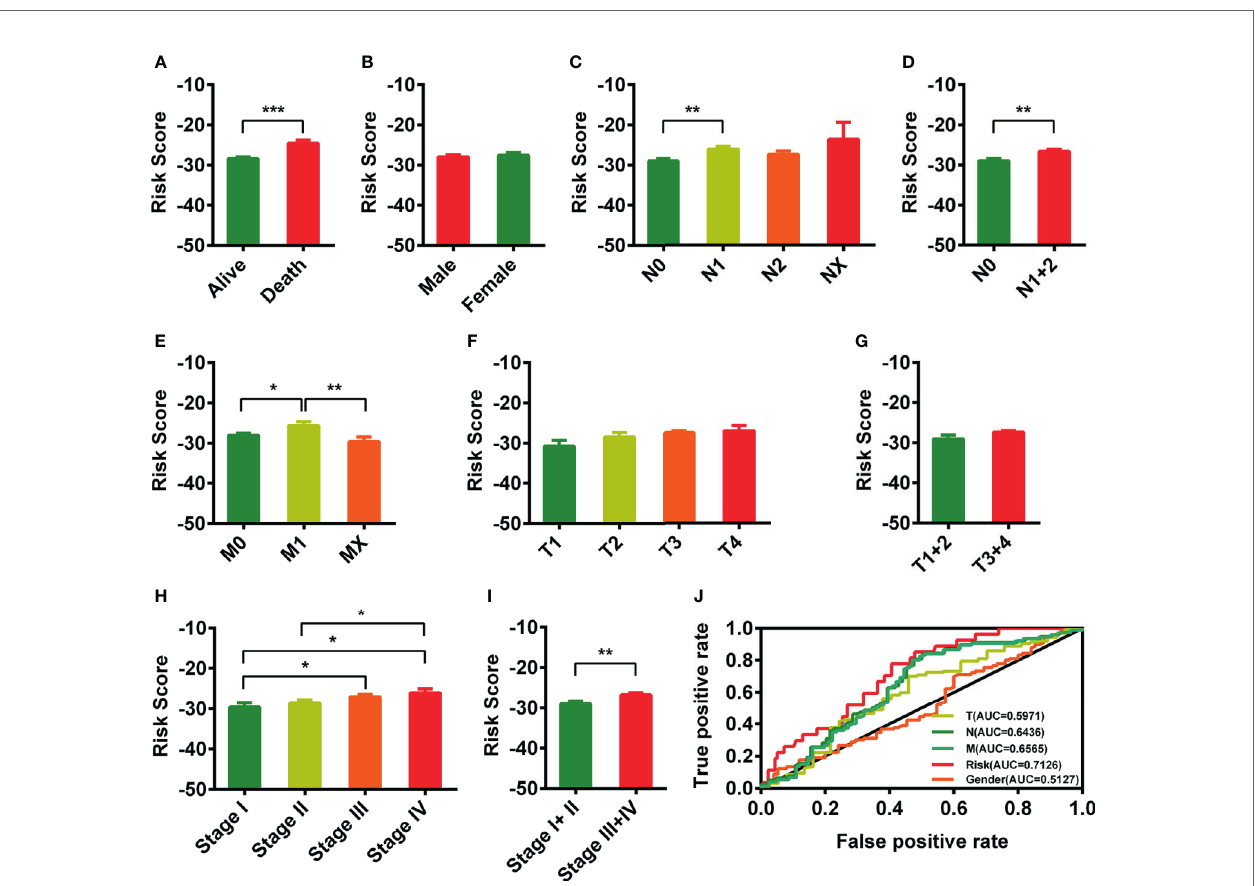
FIGURE 3 | Clinical evaluations with the risk model. (A – I) The histogram showed that vital status (A) , pathologic N (C , D) , pathologic M (E) , and pathologic stage (H, I) were signi fi cantly associated with the risk score. The risk score in different gender groups (B) and different pathologic T groups (F, G) were comparable. The lower-risk score represented lower risk in prognosis. (J) The AUC value of TNM staging, gender, and risk model. *p < 0.05; **p < 0.01; ***p < 0